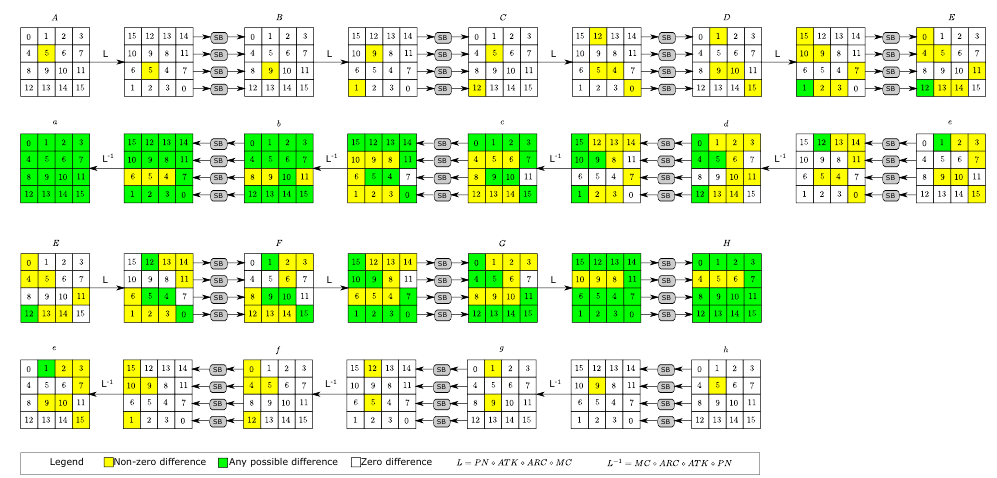
Figure 6: 7-Round E m of CRAFT